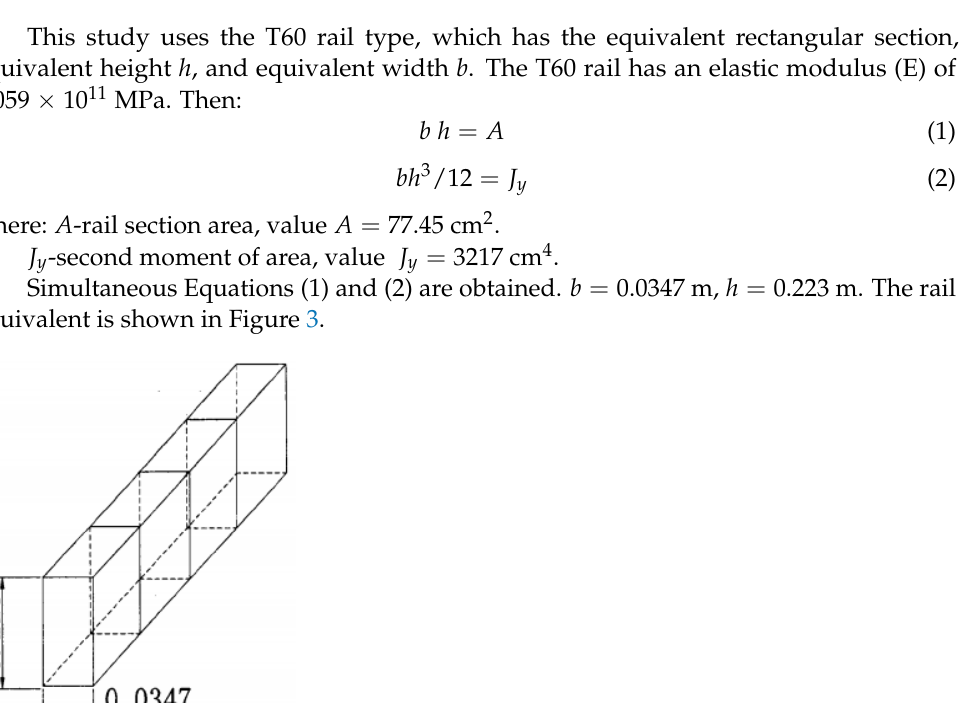
Figure 2. Elevation of the overhead system (unit: mm): ( a ) Elevation of type I overhand system. ( b ) Elevation of type II overhand system.